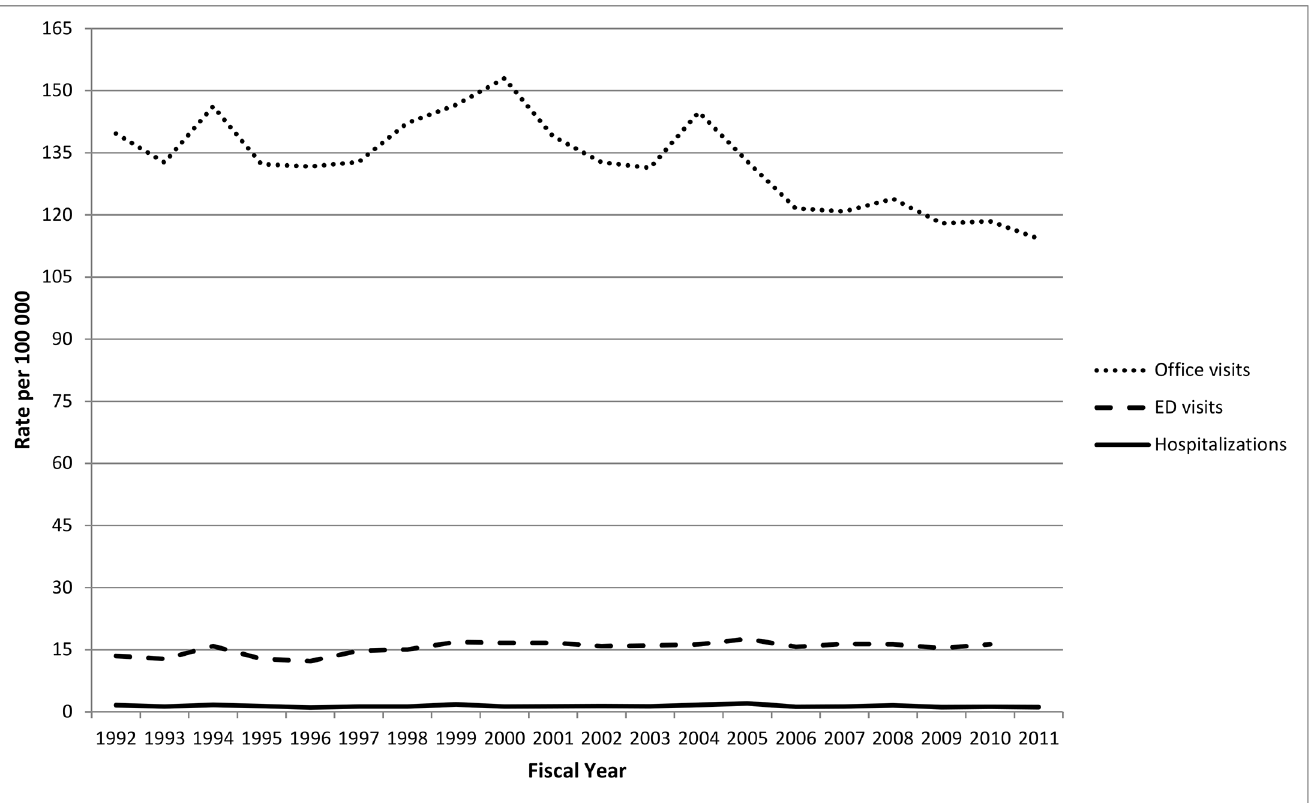
Fig 4. Incidence of herpes zoster physician office visits, ED visits and hospitalizations among Ontario children 5 – 17 years by fiscal years 1992 –